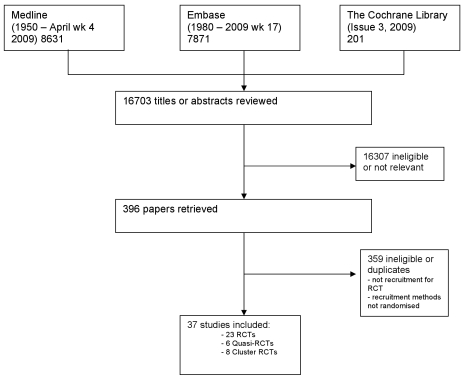
Literature search.